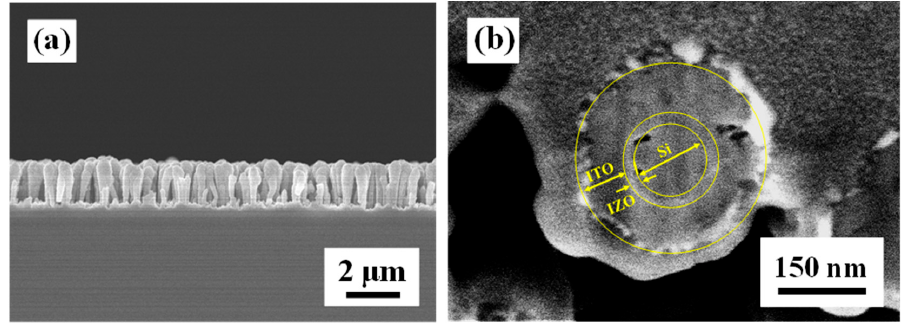
Figure 6. ( a ) Cross-sectional SEM image of the SiNWs and ( b ) the FIB image of the ITO/IZO/SiNWs.